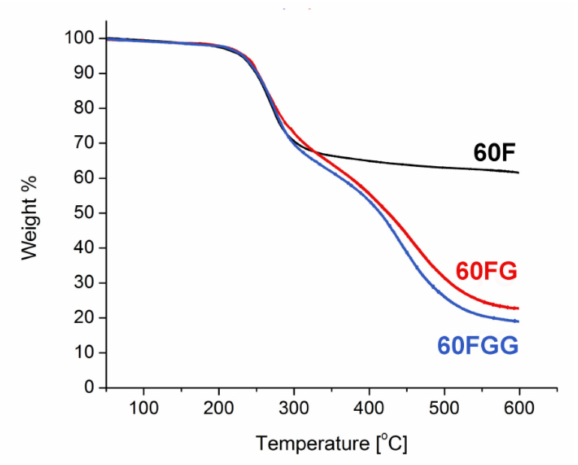
Figure 2. Thermogravimetric analysis of fullerenol ( 60F ), GLYMO modified fullerenol ( 60FG ), and gentamicin functionalized C 60 fullerene ( 60FGG ) at 5 K/min under N 2 atmosphere. Functionalization of C 60 fullerenol ( 60F ) with GLYMO allowed to form 60FG and